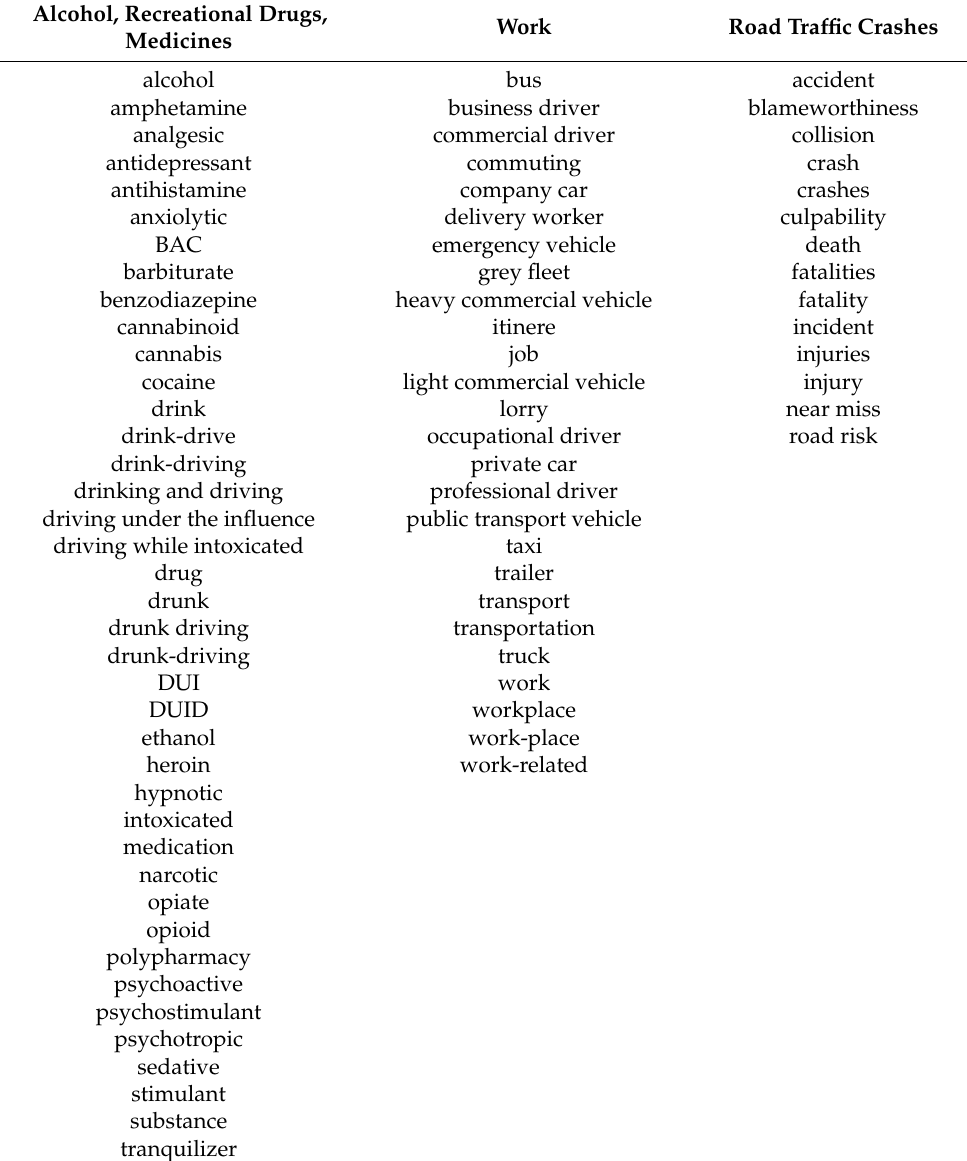
Table 1. List of keywords for each area of